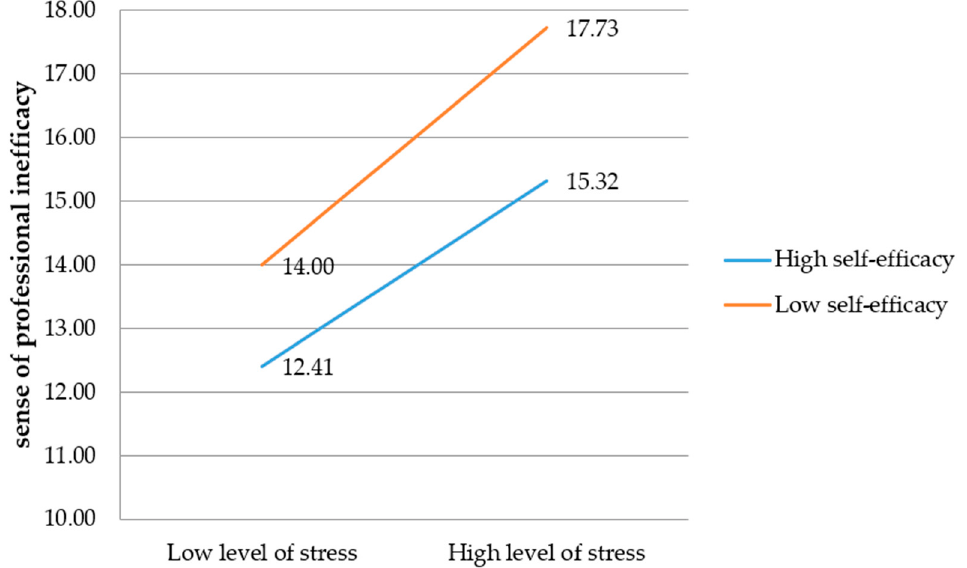
Figure 5. The impact of the sense of self-efficacy on the relationship between the level of perceived stress and the sense of professional inefficacy.